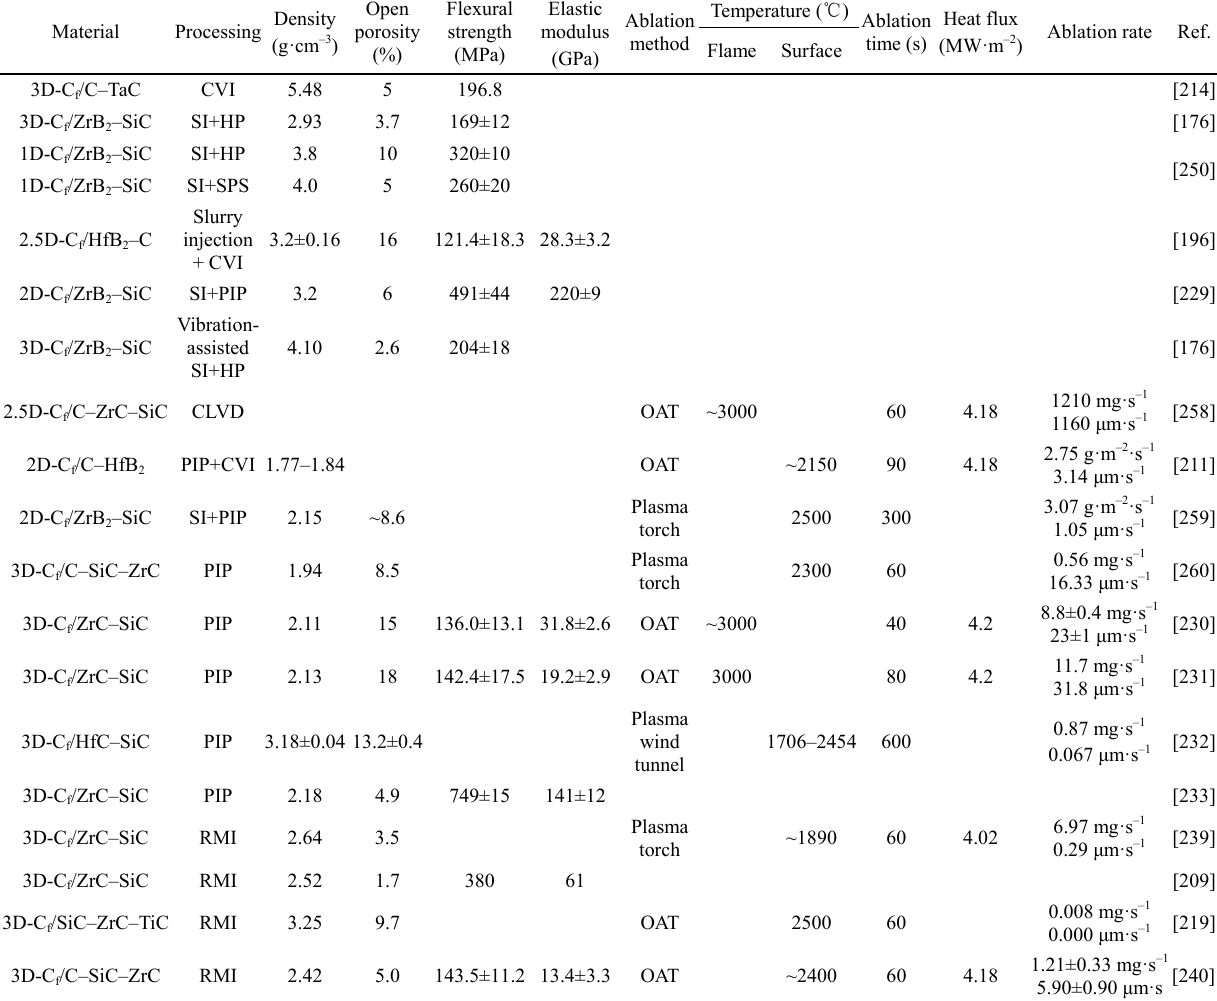
Table 4 Typical properties of UHTCMCs fabricated by various processing